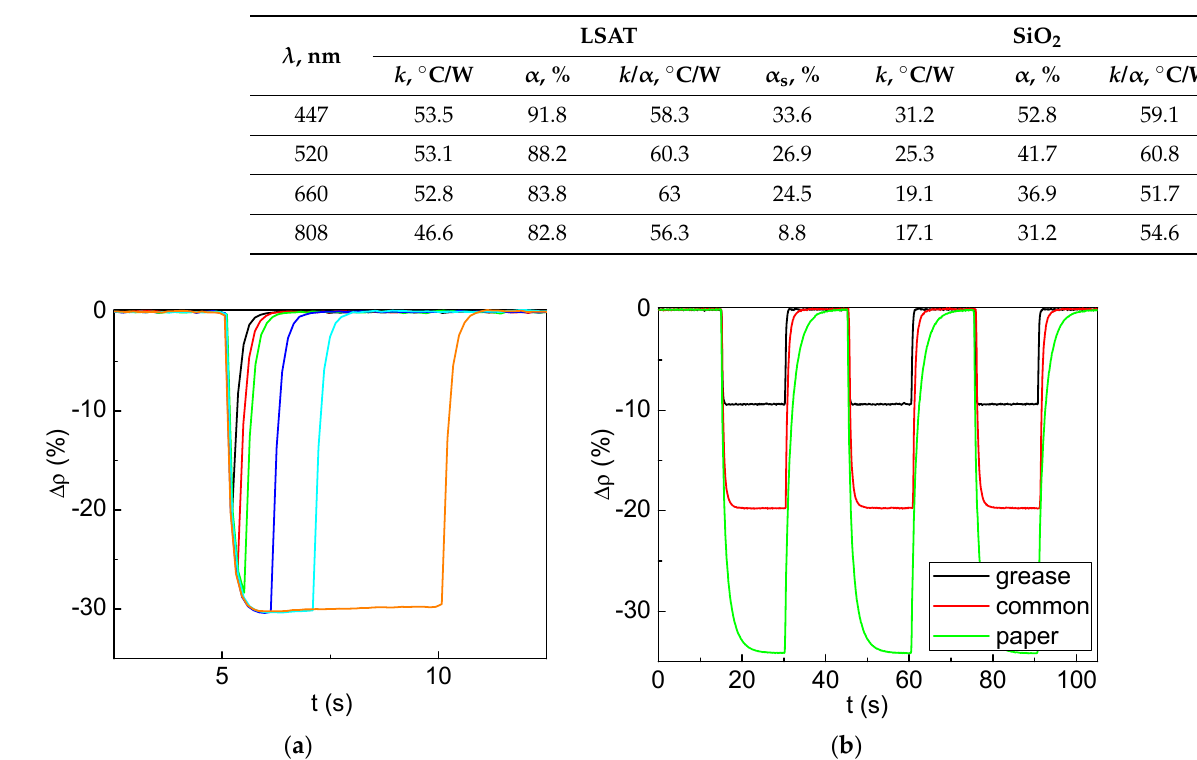
Figure 7. The percentage change of the resistivity at lighting by the blue laser on the amorphous NNO film, whose thermal contact to the temperature-controlled stage ( T = 26 °C) is varied. ( a ) Optical power is set to 0.8 W and the substrate-stage contact is improved by thermally conductive grease. Durations of the light pulse are varied as 0.1, 0.25, 0.5, 1, 2 and 5 s. ( b ) Optical power is set to 0.2 W, whereas the thermal contact between the substrate back-side and the temperature-controlled stage is varied as follows: (i) improved by thermally conductive grease; (ii) leave in the common condition of a freely lying sample; and (iii) a paper sheet of 0.1 mm thickness is placed between the substrate and the cooling stage.